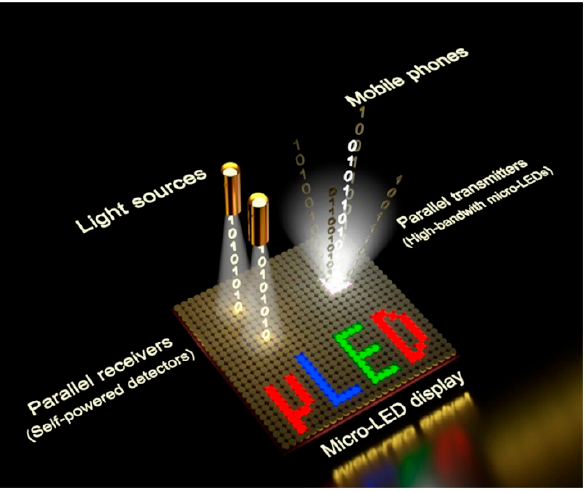
Figure 18. VLC using in information displaying signboards. Reprinted with permission from [135] . Copyright 2019, American Chemical Society.